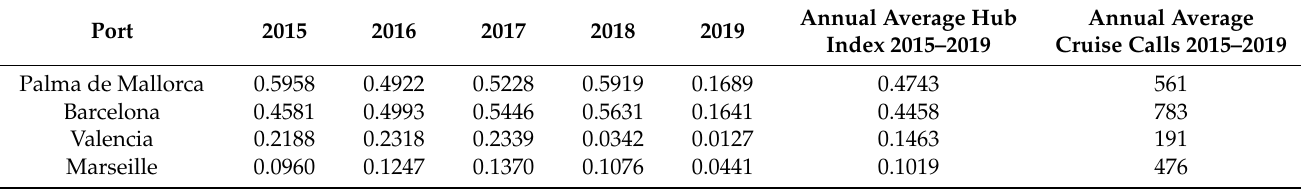
Table 10. Top 15 ports in terms of hub index and its evolution from 2015 to 2019 in the contemporary cruise network in Southern